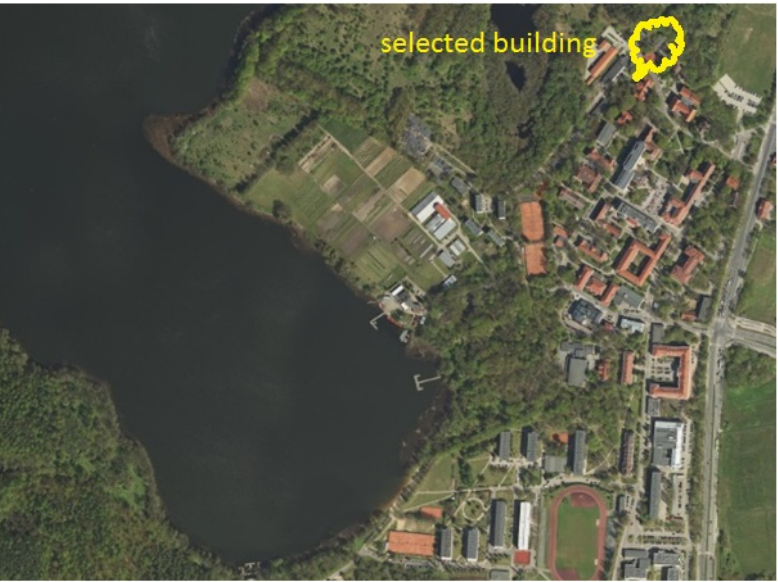
Figure 2. Part of the UWM campus with selected building, https://msipmo.olsztyn.eu/imap/ (accessed on 21 March 2022).